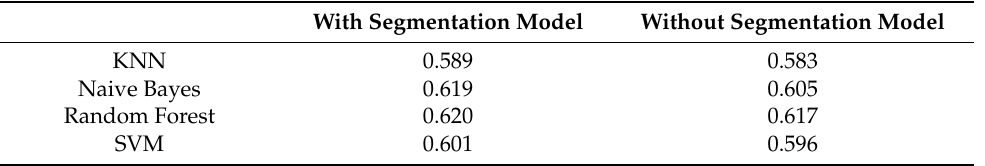
Table 4. The comparison of the correlation coefficient with the segmentation model and without segmentation